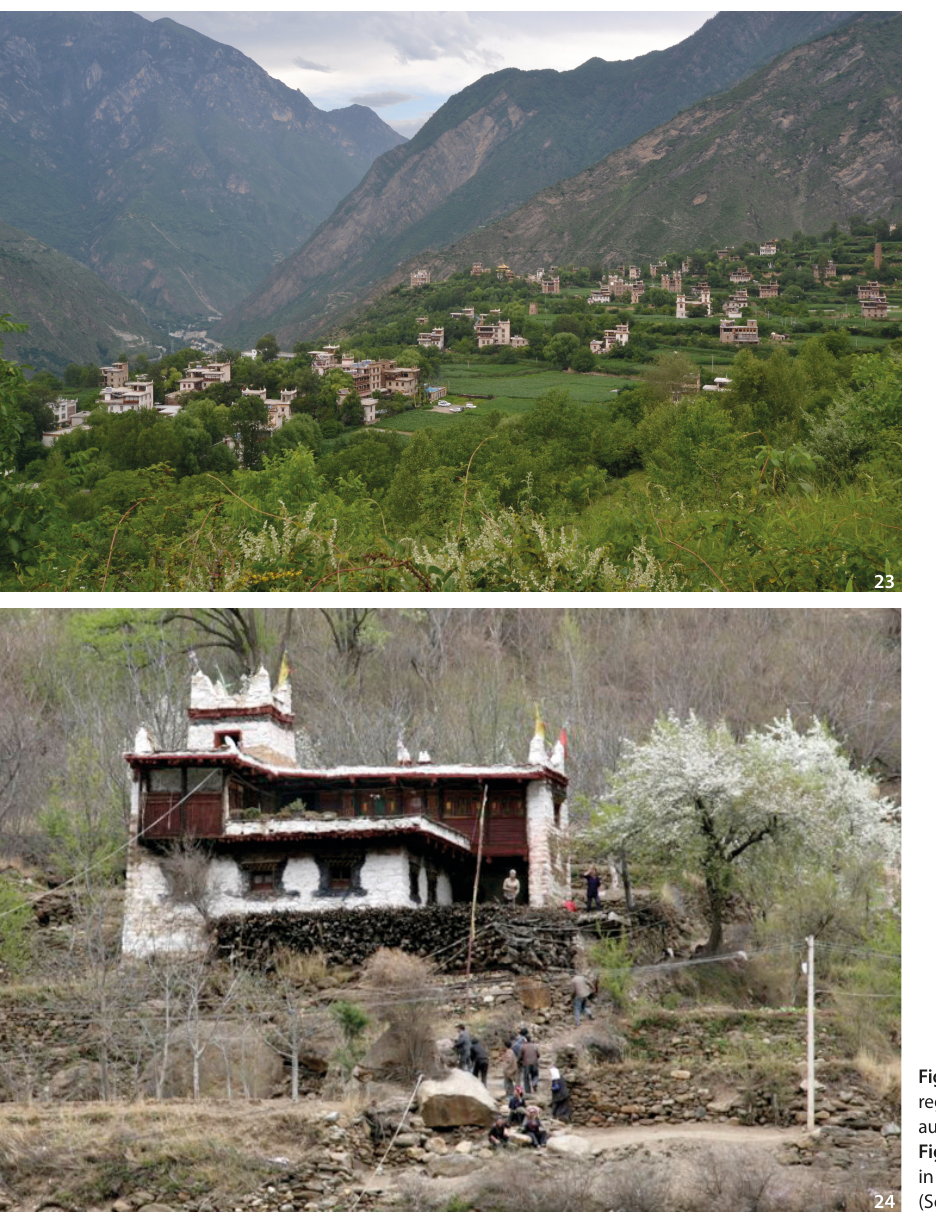
Figure 23 Zhonglu Village in the region of Gyalrong (Source: the authors). Figure 24 View of the farmhouse in Gyalrong from the southwest (Source: the